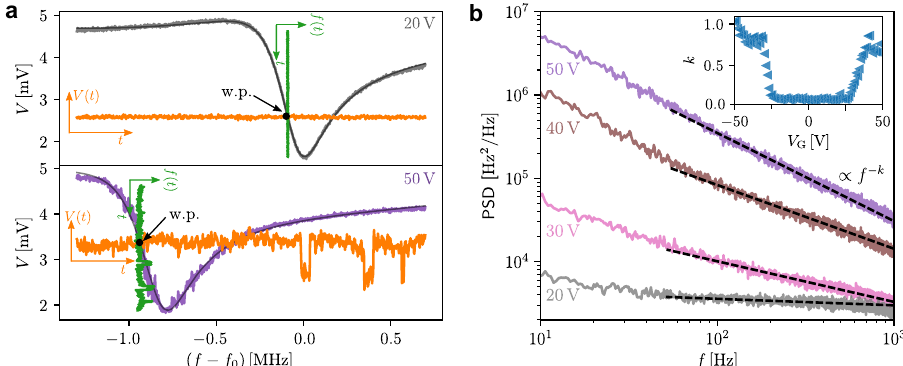
Fig. 2 Noise properties of the superconducting coplanar resonator. a Principle of the frequency noise measurements. Examples of resonance curves at 20 V (top panel) and 50 V (bottom panel) gate voltage applied to the Dayem bridge. At each gate voltage, the steepest point of the magnitude of the resonance is used as the working point (w.p.) for time trace measurements. Examples of voltage and frequency fl uctuations with a duration of 1 s are shown in orange and green colours, respectively. b Power spectral density (PSD) of fl uctuations at various gate voltages. Dashed lines are the fi ts of PSD functions by ∝ f − k . Inset shows the dependence of the fi tted exponent k on the gate voltage at 10